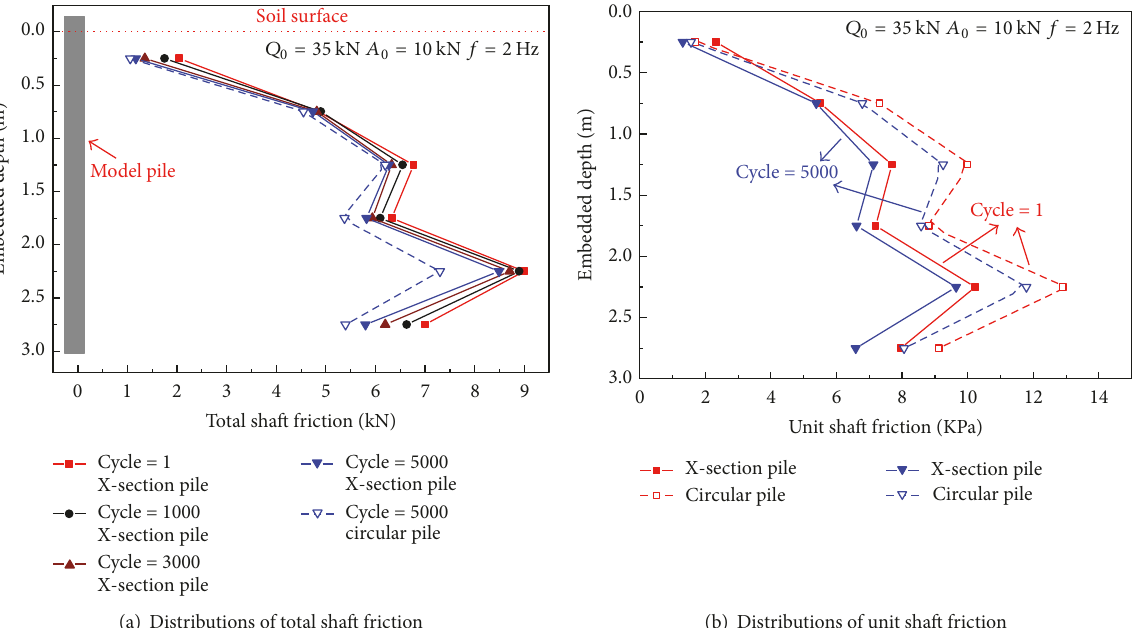
Figure 11: Distribution curves of shaft friction.